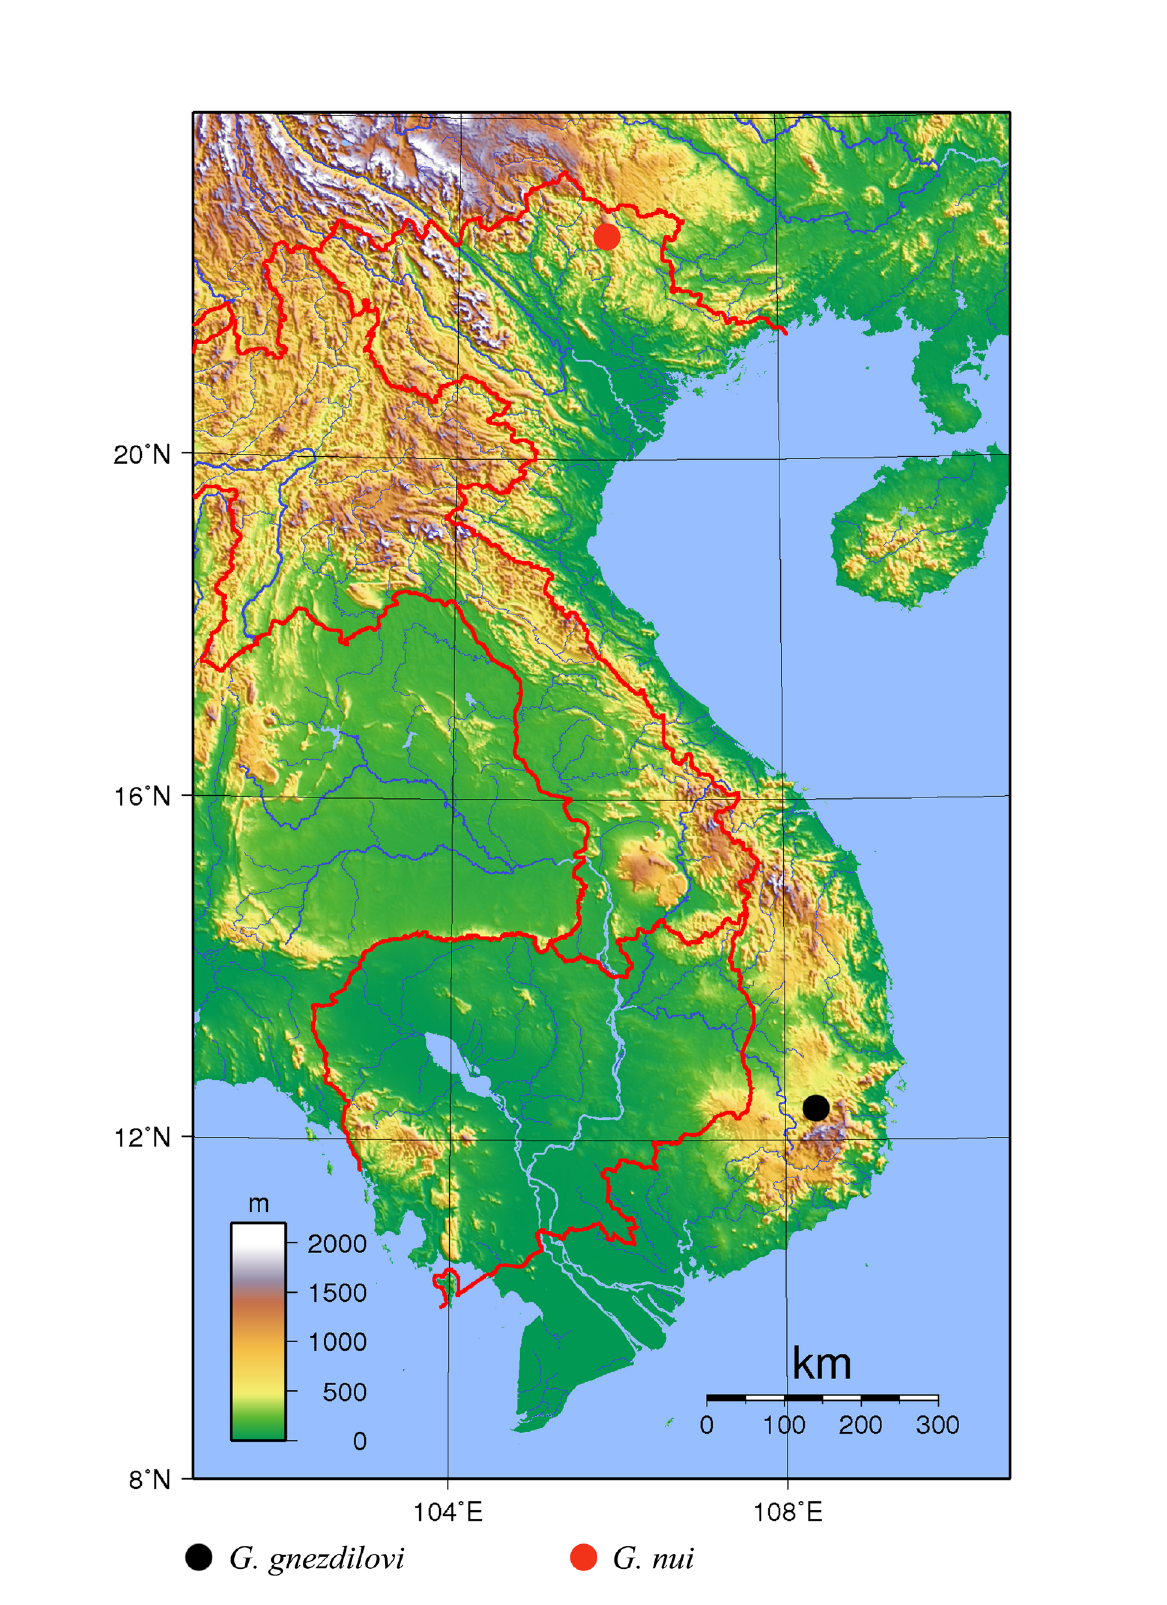
Fig. 5. Distribution map of Gergithoides gnezdilovi sp. nov. and G. nui sp.